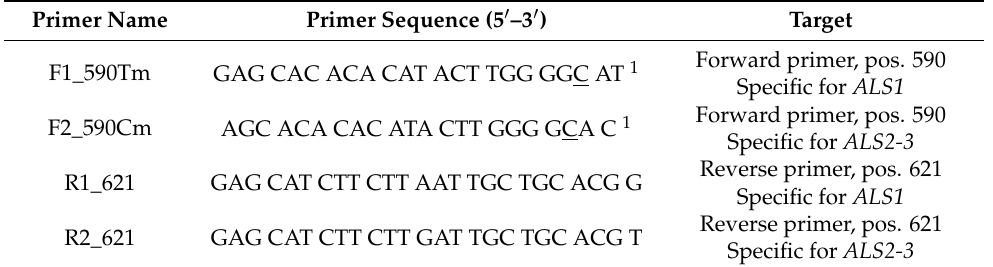
Table 2. List of primers used for the study of relative expression of the different ALS gene